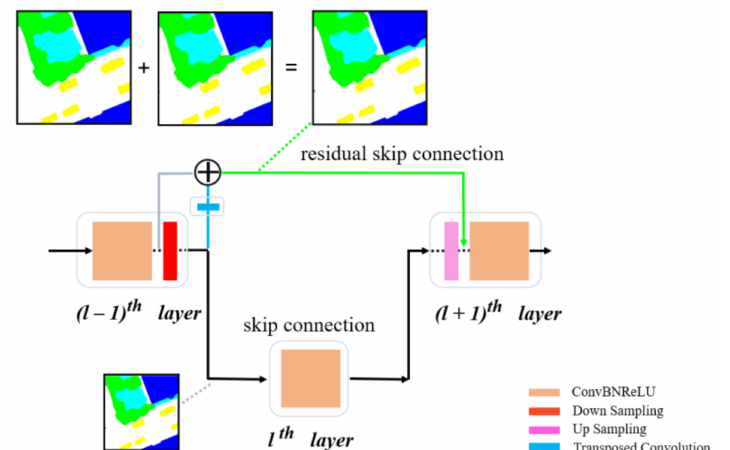
Figure 5. The architecture of the residual skip